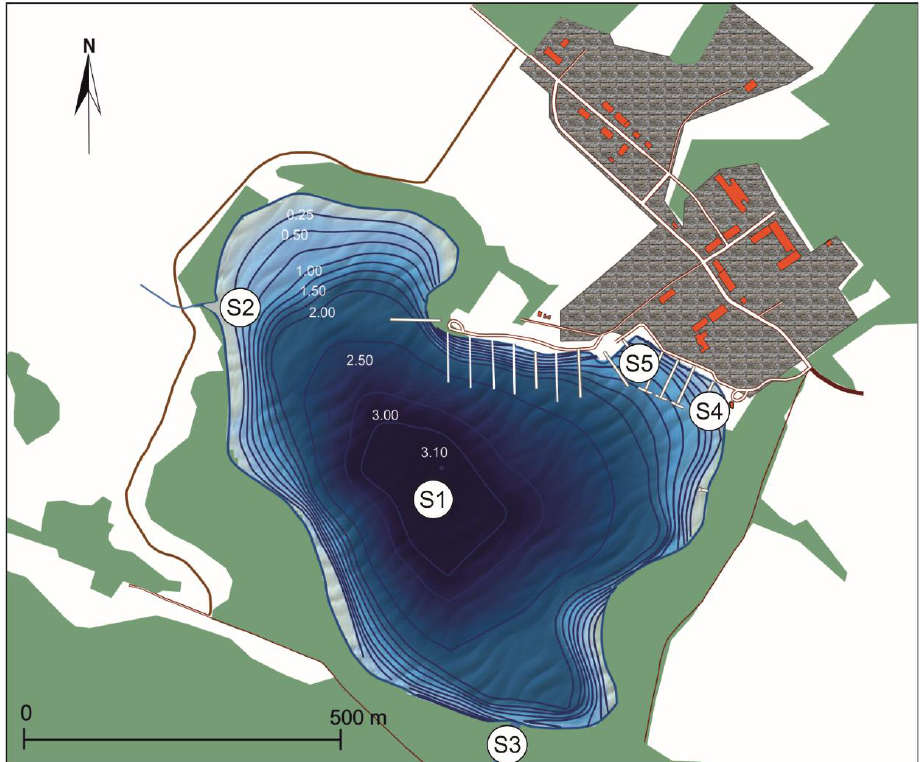
Figure 1. Bathymetric map and location of sampling sites in Lake Sztynorckie (after IRS 1950, modified); site S1–profundal zone; site S2—inflow zone; site S3—channel zone; site S4—fuel zone; site S5—mooring zone.